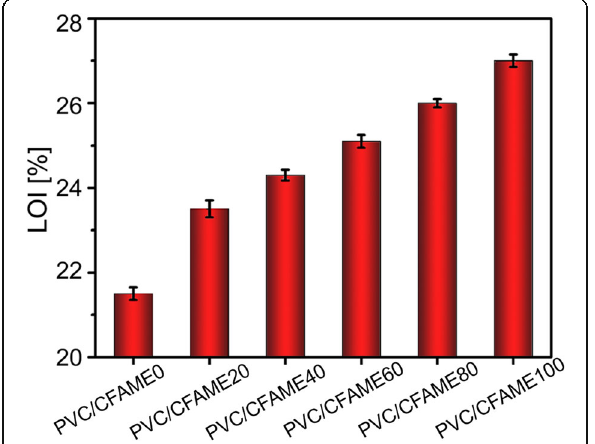
Fig. 7 LOI of PVC/CFAME x